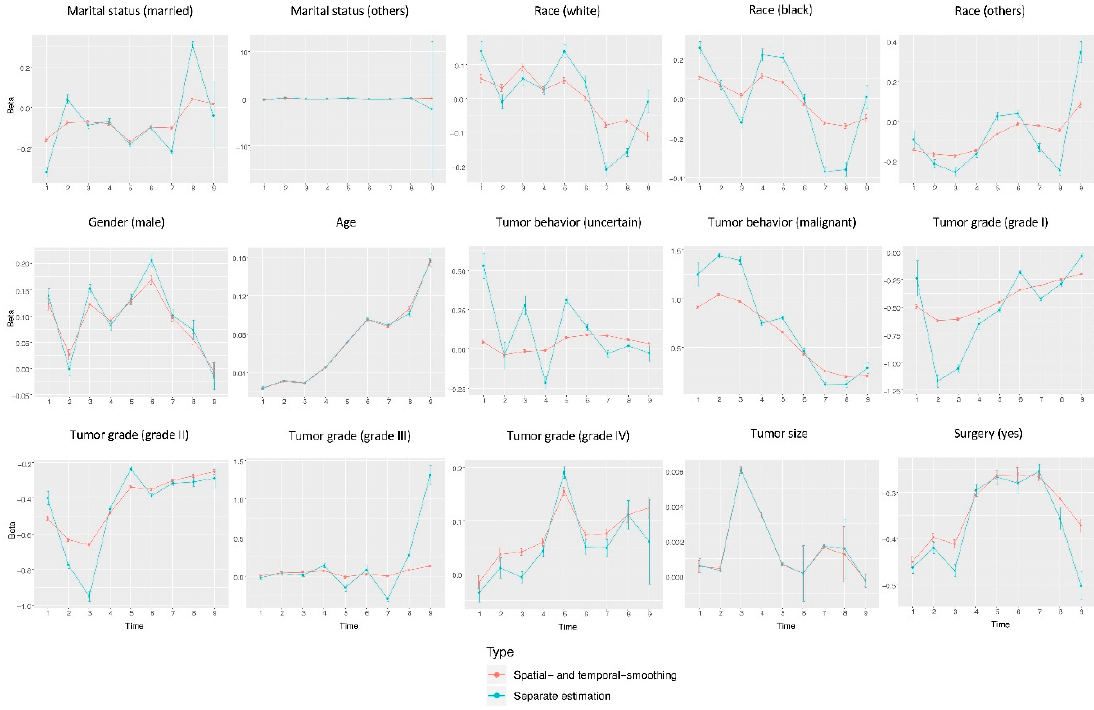
Figure 2. Representative analysis results using the proposed (red) and separate (blue) estimations: estimated coefficient and 95% confidence interval (vertical bar) for each variable at each time interval and location = San Francisco-Oakland.